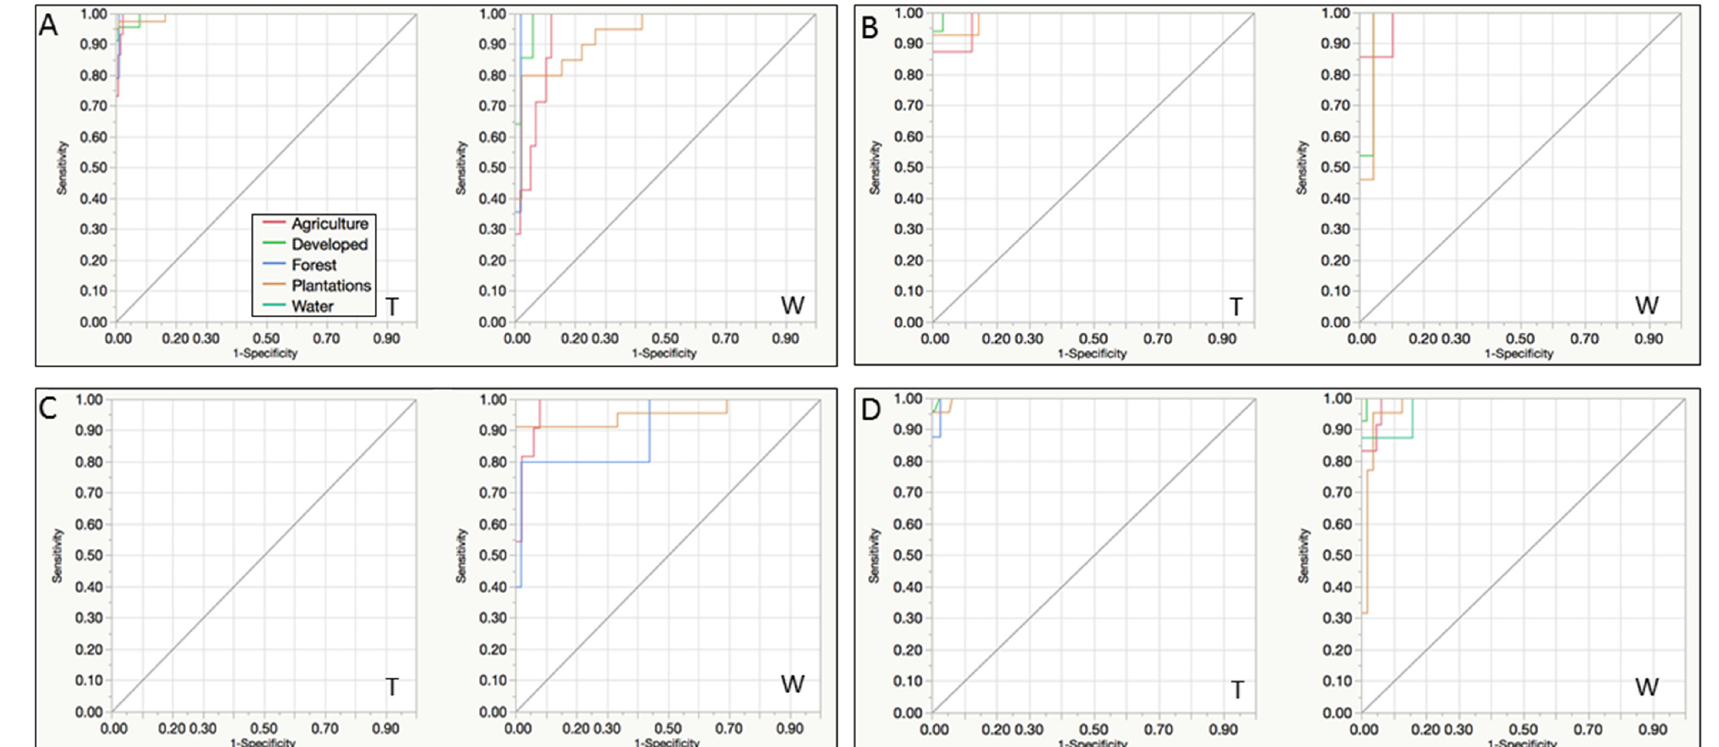
Figure 8. ROC training (T) and withheld (W) curves shown for West Kalimantan, Indonesia for classifying agriculture, developed, forest, plantation, and water using ( A ) Landsat 8 OLI; ( B ) PALSAR-2; ( C ) Sentinel-1;and ( D ) fused/combined imagery.